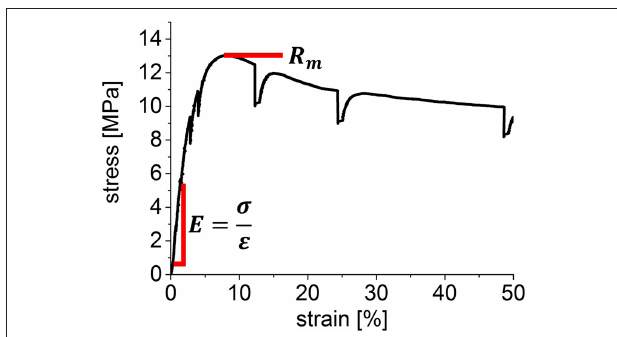
FIGURE 3 | Representative stress-strain curve of non-filled PEO with characteristic parameters marked on the graph showing the mechanical material properties by tensile strength R m and Young’s modulus E. The drops in stress during constant tensile strain result from required stops during the measurements necessary to record X-ray diffraction patterns with larger accuracy.